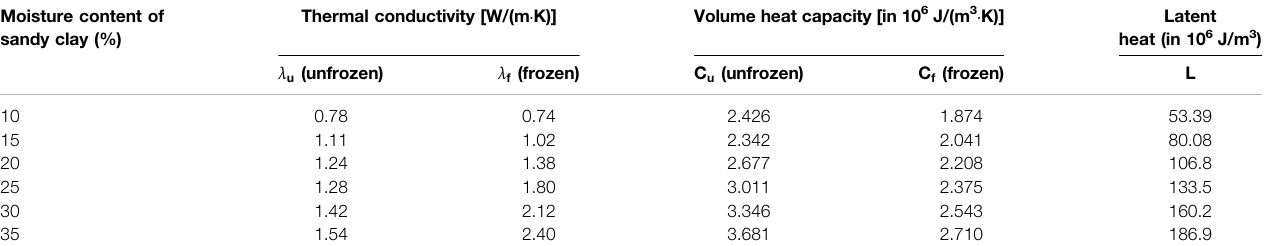
TABLE 3 | Physical parameters of sandy clay at different moisture content (Chen et al., 2018; Han et al., 2019; Xu et al., 2001). Moisture content of sandy clay (%)